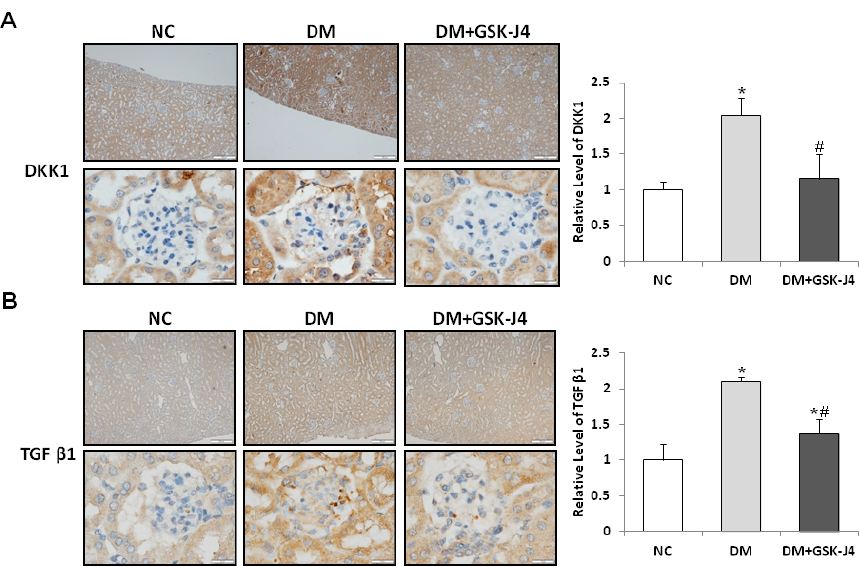
Figure 2. GSK-J4 reduces DKK1 and TGF- β 1 expression in the glomeruli of STZ-induced diabetic mice. The mice were divided into three groups: normal mice (NC), STZ-induced diabetic mice (DM), and STZ-induced diabetic mice with GSK-J4 treatment (DM + GSK-J4). Immunohistochemistry detection for related proteins of DKK1 ( A ), and TGF- β 1 ( B ). The right panel shows the relative quantification of DKK1 and TGF- β 1 in the tissue immunostaining analysis. The average ratio of the integrated optical density (IOD) to the area (IOD/pixel) was used to analyze the results of immunohistochemistry. The statistical results were compared with the normal control (NC) group. * p < 0.05 versus the control group; # p < 0.05 DM versus DM + GSK-J4. Data are mean± standard errors calculated from six mice. Abbreviations: DKK1, dickkopf-1; DM, STZ-induced diabetic mice; NC, normal mice; and TGF- β 1, transforming growth factor β 1. (Enlargement factor: upper, 100×; lower, 1000×).